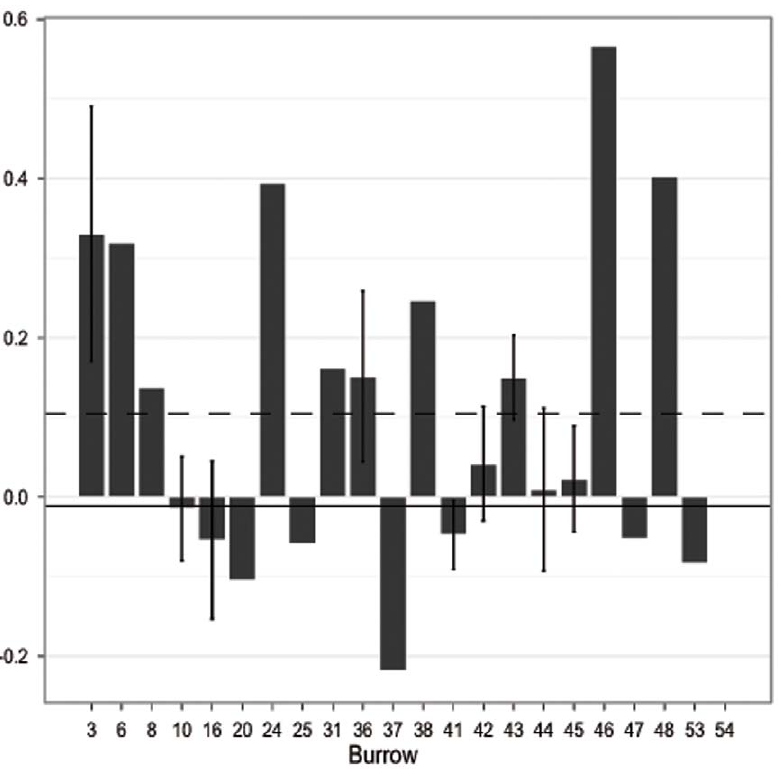
Figure 3. Relatedness of individuals within burrows. Mean ( 6 1SE) relatedness coefficient, R [43], for 22 burrows containing two or more individual P. vlangalii . The dashed line indicates the overall mean burrow relatedness while the solid line is the population mean relatedness.